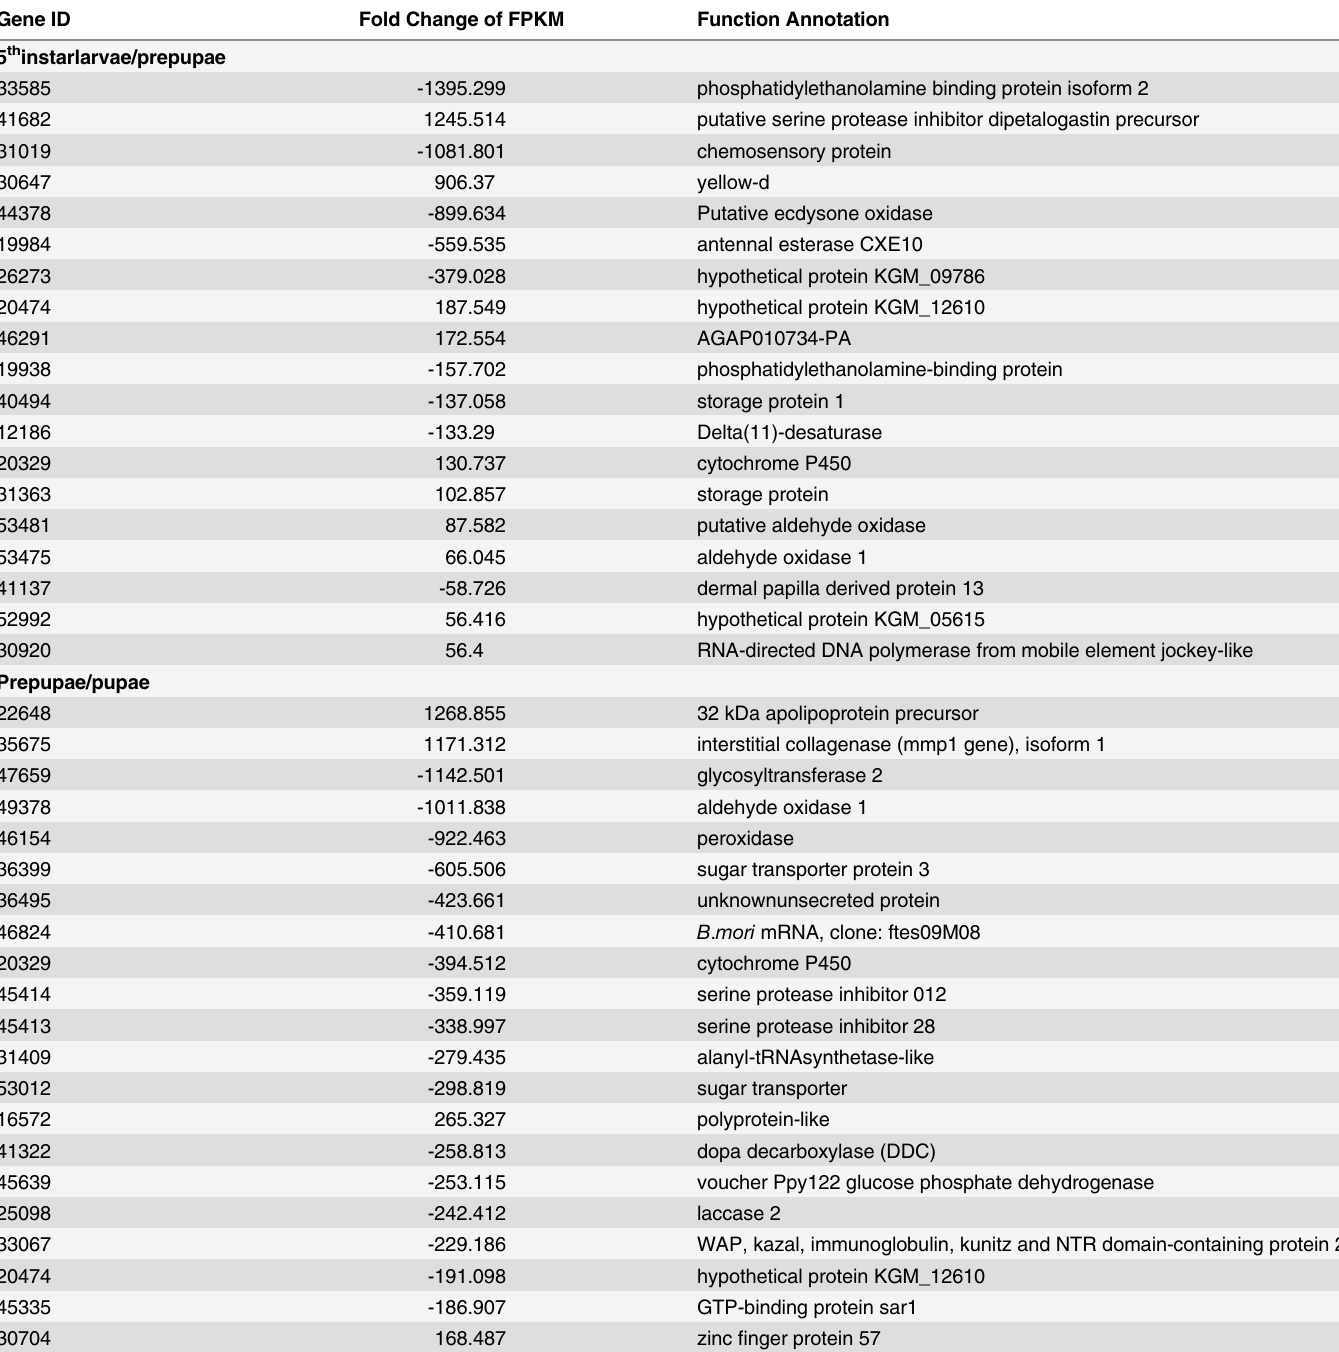
Table 6. Twenty of highly differentially expressed annotated genes in the 5th instar larvae/ prepupae and prepupae/pupae libraries based on expressed tag frequency. “ - ” indicates down